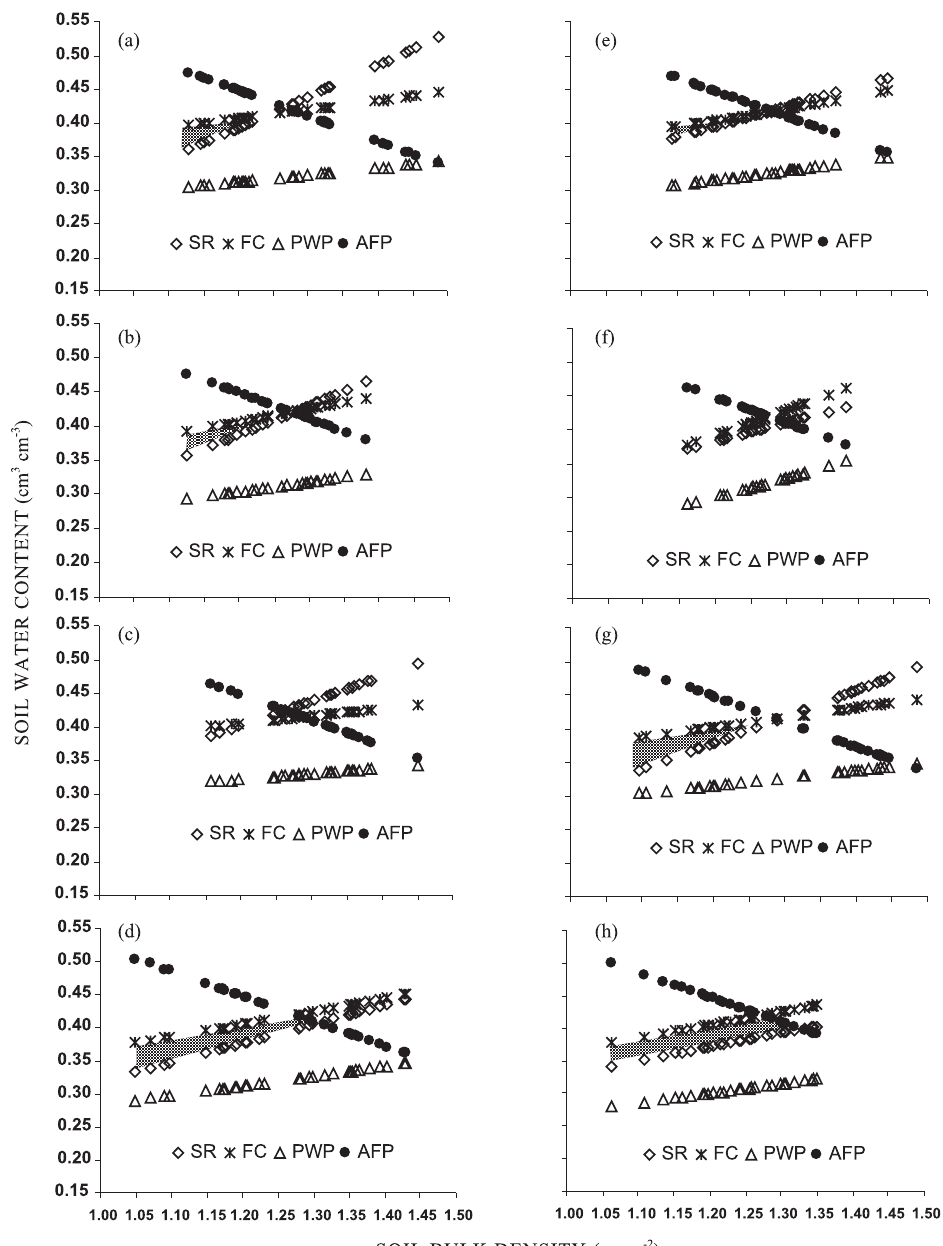
Figure 1. Soil water content ( θθθθθ ) as affected by soil bulk density, at the critical levels of field capacity (FC = -0.01 MPa), permanent wilting point (PWP = -1.5 MPa), air-filled porosity (AFP = 10 %) and soil penetration resistance (SR = 2MPa). Samples collected in the 0–20 cm layer, in the first year of the experiment. The shaded area represents the LLWR. (a) sunflower+millet; (b) sunflower+forage sorghum; (c) sunflower+sunn hemp; (d) sunflower+chiseling; (e) triticale+millet; (f) triticale+forage sorghum; (g) triticale+sunn hemp; (h)